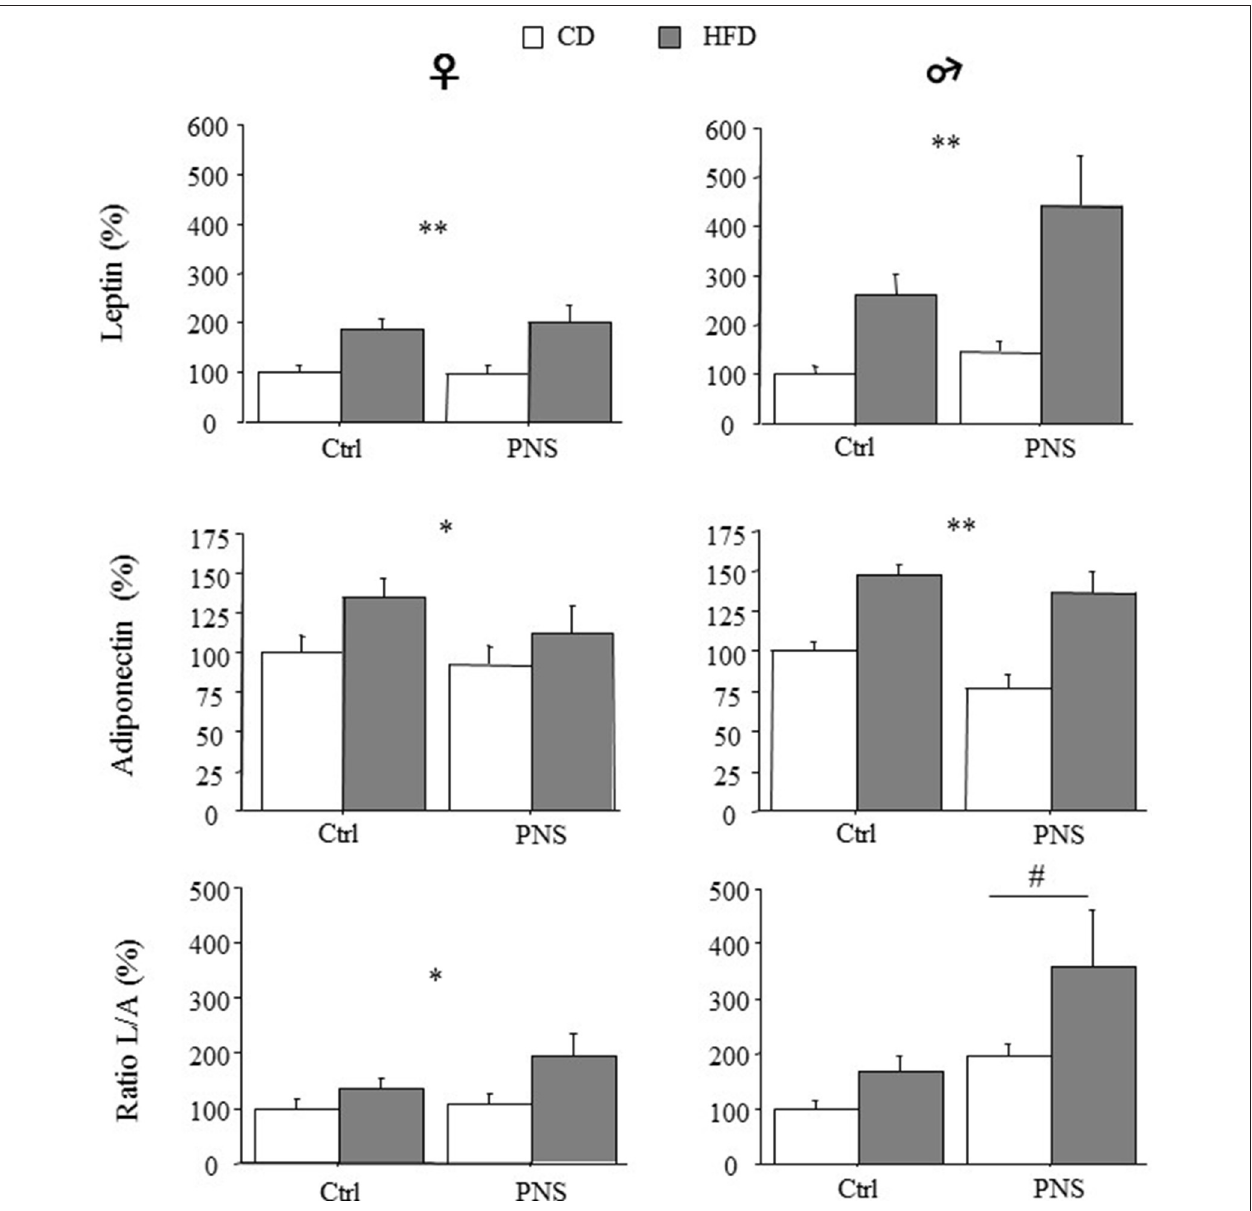
FIGURE 3 | High-fat diet increased relative (% of control) circulating leptin and adiponectin levels in both female and male subjects (HFD vs. CD). High fat diet feeding increased the leptin/adiponectin (L/A) ratio - an index of metabolic risk - in females (CD vs. HFD) but in males a greater increase was observed as a result of Prenatal Condition (PNS vs. Ctrl). Data are presented as means + SEM. Data are shown: * p < 0.05; ** p < 0.01, main effect of HFD; # p < 0.05, main effect of Prenatal Condition.